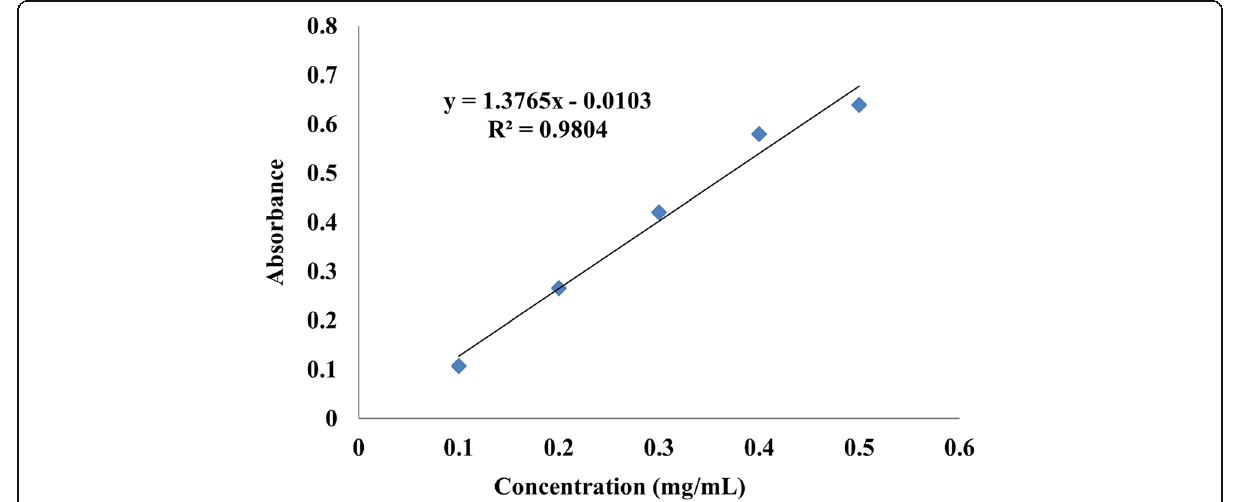
Fig. 3 Total tannin content determination of Merremia umbellata extract with the help of gallic acid standard calibration curve